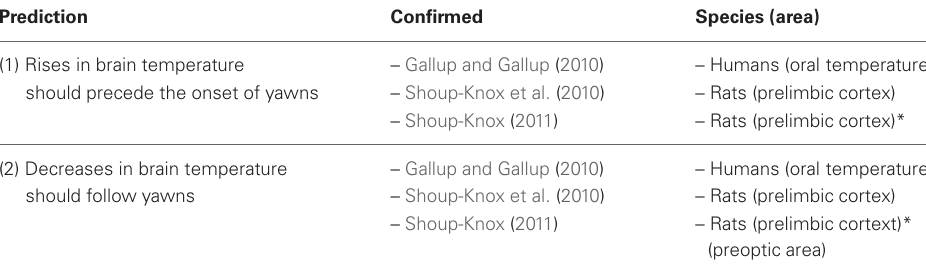
Table 1 | Empirical tests of the brain cooling hypothesis.